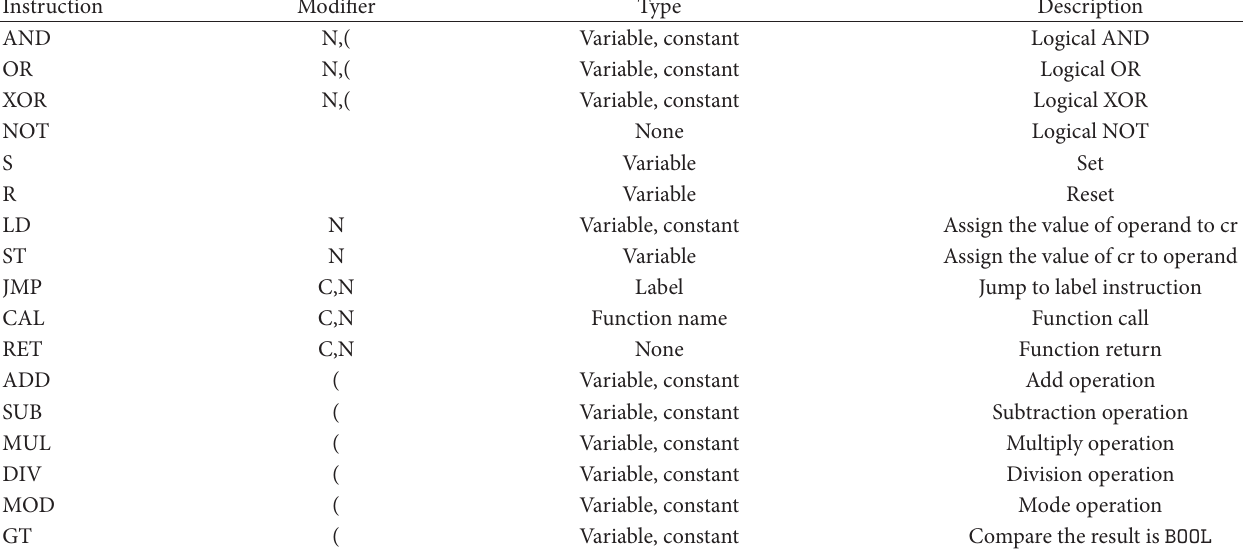
Table 1: The meaning of IL